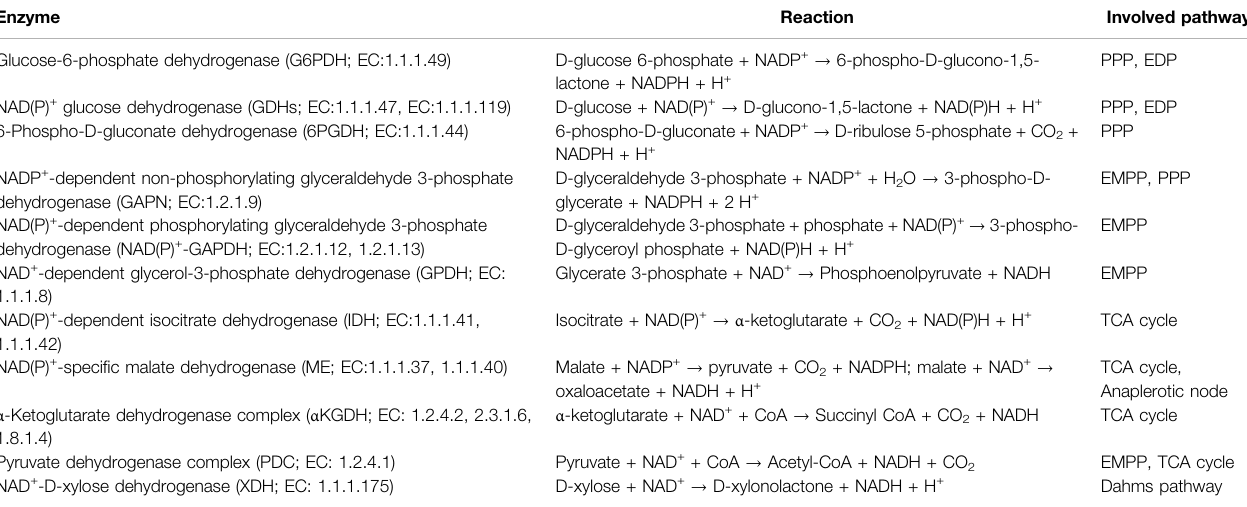
TABLE 1 | NAD(P)H generating enzymes in central carbon metabolism. Enzyme Reaction Involved